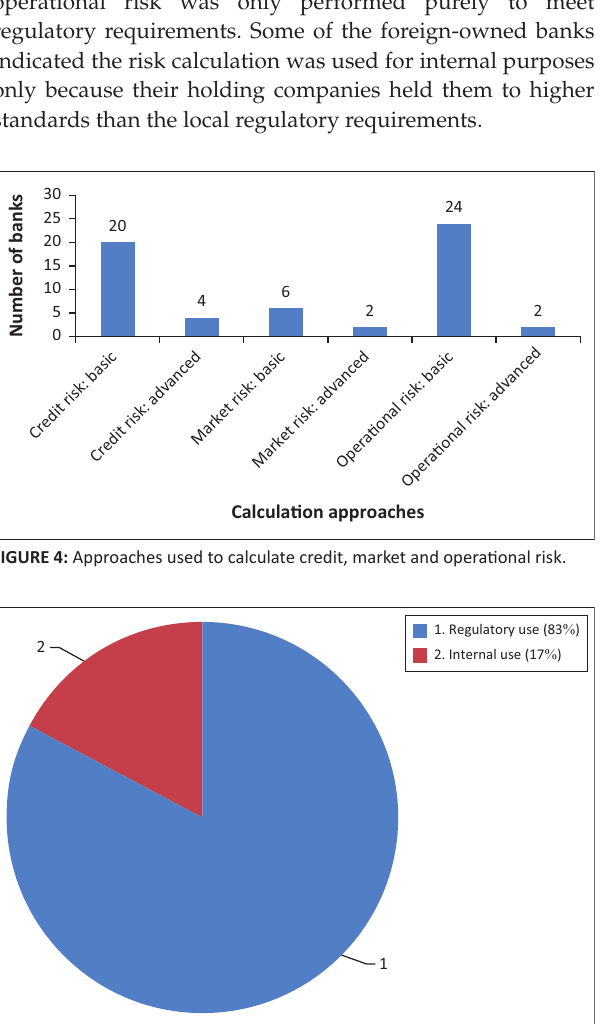
Figure 6 indicates bank departments responsible for the